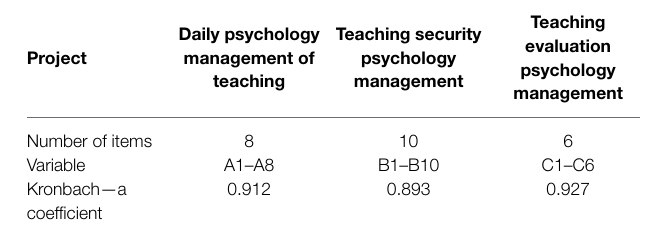
TABLE 2 | Reliability analysis of indicators at all levels.